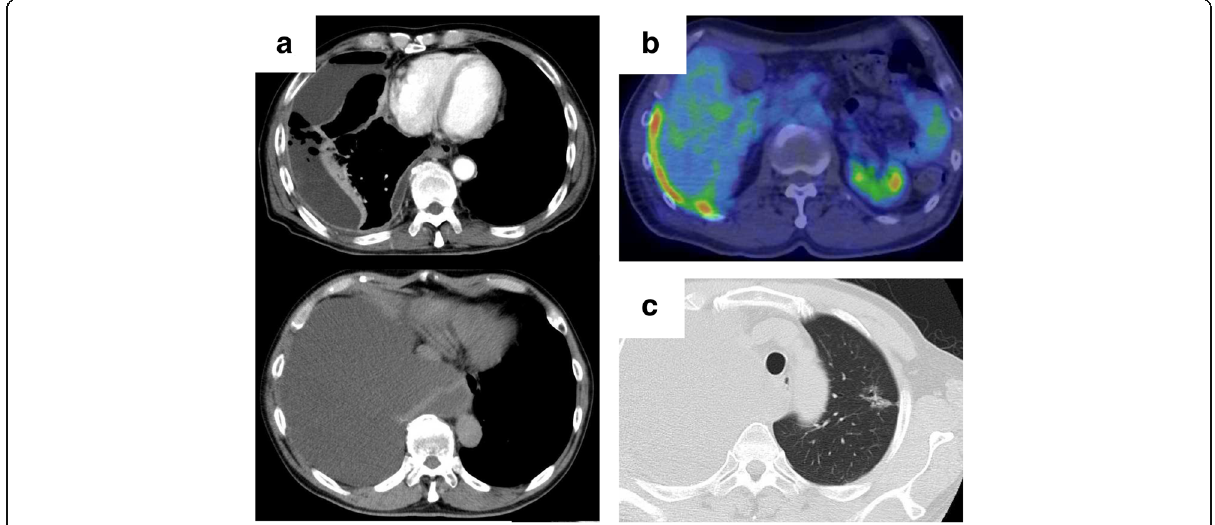
Fig. 2 a Chest computed tomography (CT) at presentation showing right pleural effusion and focal thickening of the parietal pleura. b Positron emission tomography (PET) showing a moderate uptake of flouro-deoxy-glucose (FDG) with the maximum standardized uptake value of 6.6 in the thickened pleura. c Chest CT revealing a 2.5-cm “ part-solid ” ground-glass opacity (GGN) in the upper division of the left